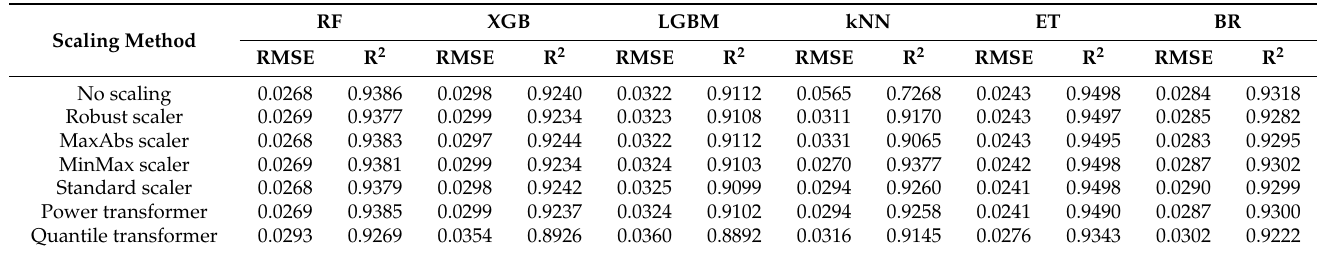
Table 6. The effect of different scalers on TRP prediction in the River Enborne.